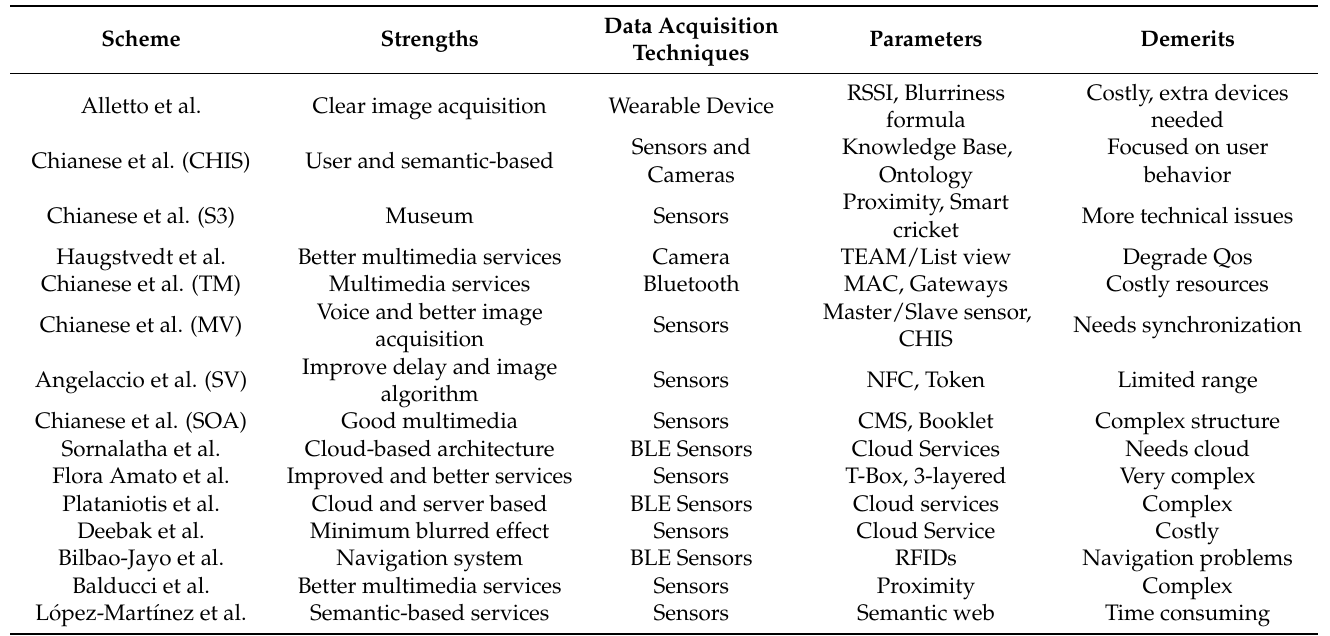
Table 1. Summary of